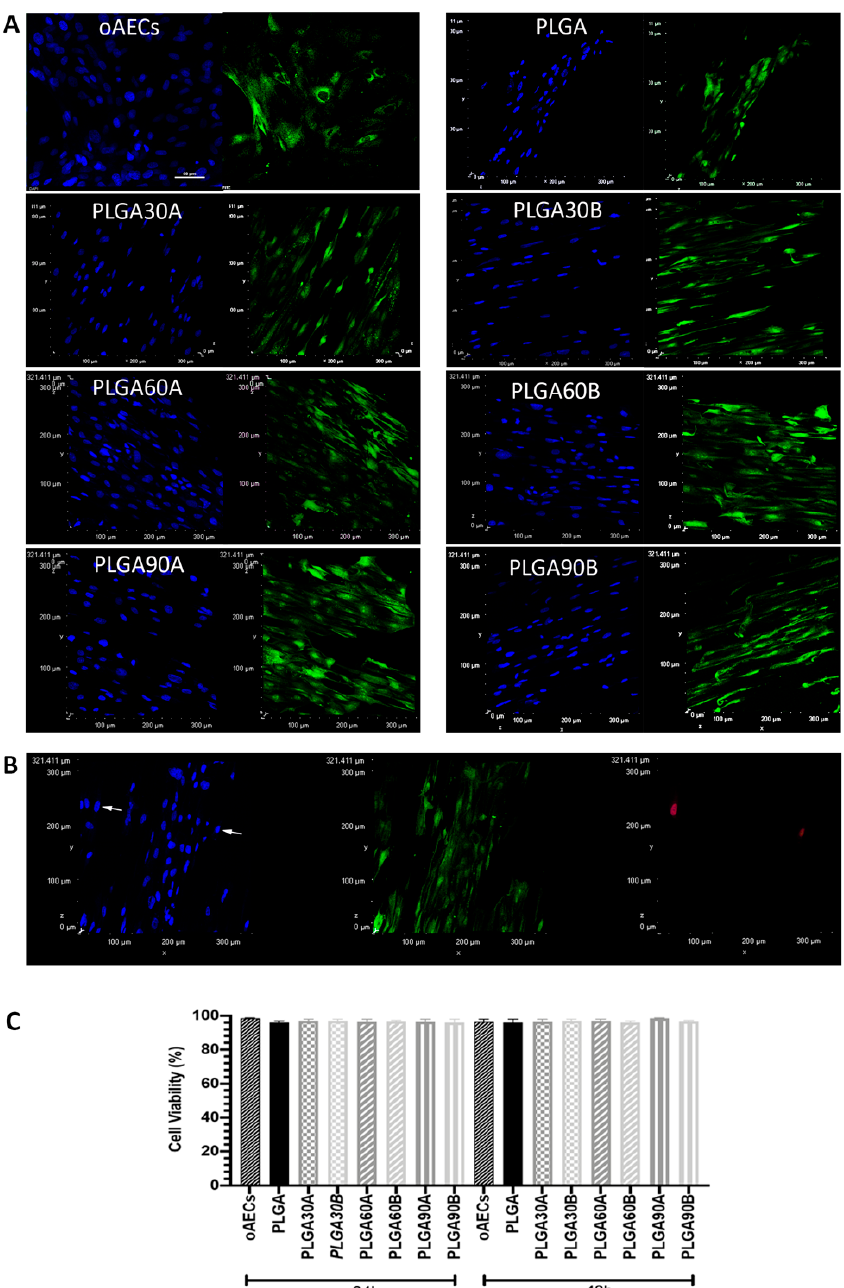
Figure 5. Ovine amniotic epithelial stem cell (oAECs) viability on Petri dishes, untreated and CAP treated electrospun PLGA microfibers. ( A ) Representative images of oAECs survival on Petri dishes, untreated PLGA and CAP treated PLGA microfibers stained with Calcein AM / propidium iodide stains (green and red fluorescence, respectively) after 48 h of culture. Nuclei were counterstained with Hoechst 3342 (blue fluorescence). In these figures the red channel (TRITC) is not shown since the stained cells were all negative to propidium iodide (dead cell marker, red fluorescence) confirming the high vitality of oAECs within the di ff erent groups of PLGA microfibers; scale bar = 50 µ m. ( B ) Representative image showing few red dead nuclei (propidium iodide, red fluorescence) in electrospun PLGA microfibers. ( C ) Histogram showing oAECs viability of cells cultured on Petri dish (oAECs), seeded on untreated PLGA (PLGA) and di ff erent CAP treated PLGA microfibers, after 24 h and 48 h days of culture. All untreated and CAP treated PLGA microfibers are biocompatible for oAECs since no statistical di ff erence was evident among the di ff erent groups ( p > 0.05); ( n = 3 for each type of fleece / time point, fleece size: 15 mm × 7